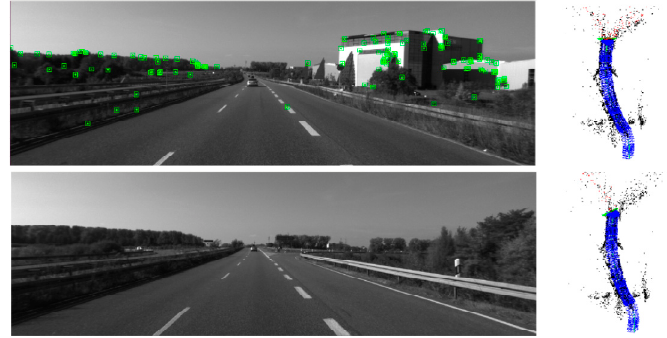
Figure 12. The lost ORB features during tracking on the sequence 01 of KITTI dataset.